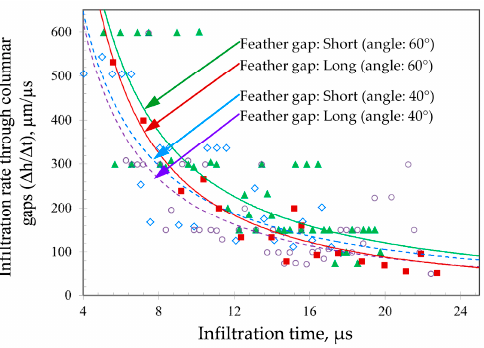
Figure 16. Simulated infiltration rates in columnar gaps compared for short and long feather arm models considering 40° and 60° feather arm inclination.